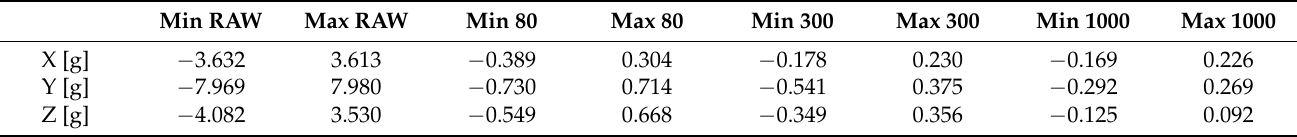
Table 5. Maximum accelerations and decelerations in RAW, 80-, 300-, and 1000-ms evaluation times (Authors). Min RAW Max RAW Min 80 Max 80 Min 300 Max